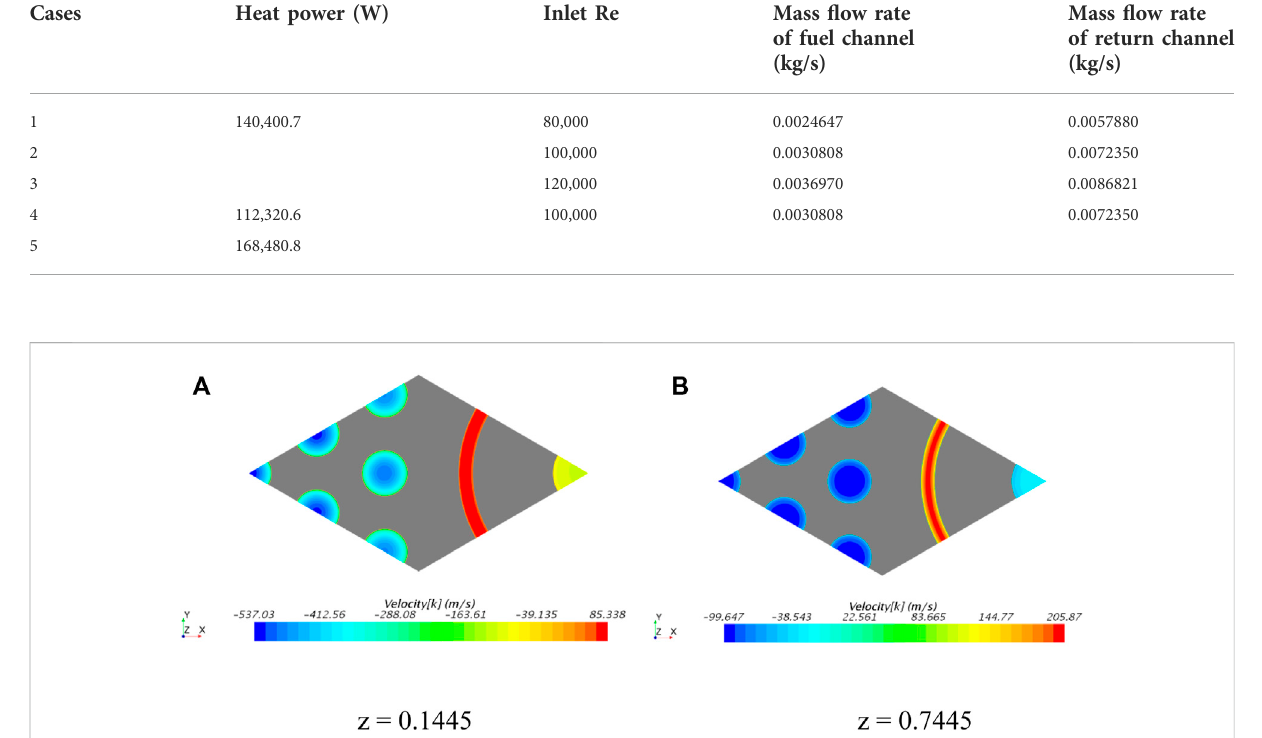
FIGURE 7 Cross-sectional pro fi les of velocity magnitude in case 2. (A) cross-sectional pro fi le while height is equal to 0.1445. (B) cross-sectional pro fi le while height is equal to